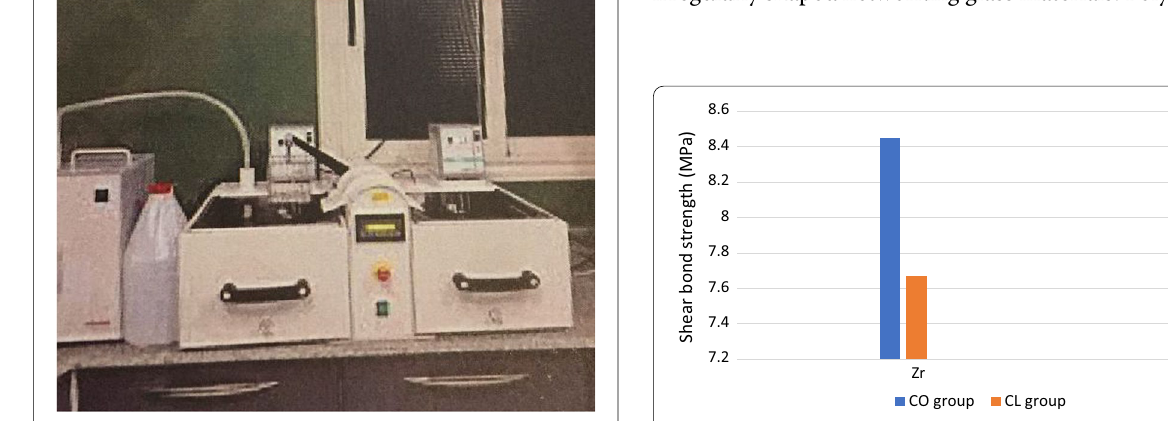
Table 2 This Descriptive statistics of shear bond strength results (mean values SDs) for both groups